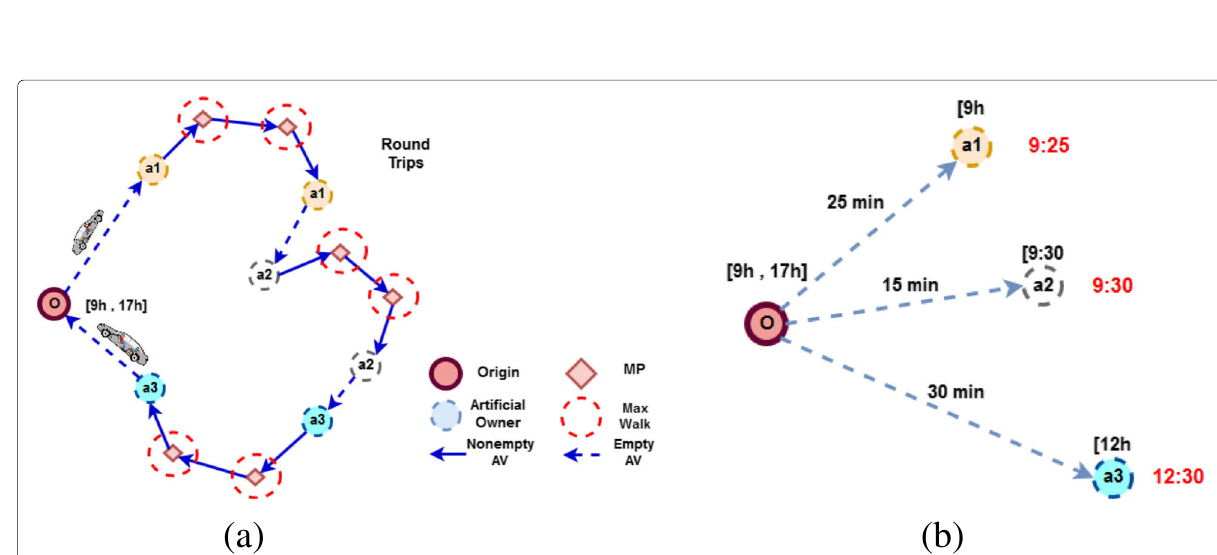
Fig. 5 Generating feasible matches for a round trip. a Artificial Owners b Choosing the next